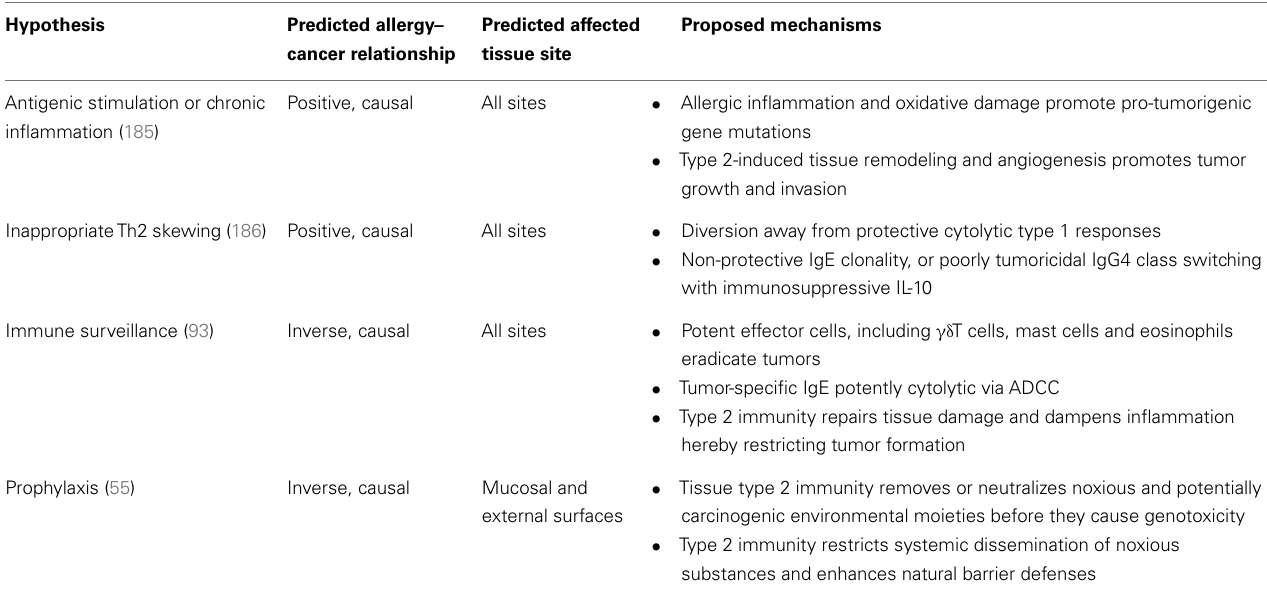
Table 2 | Proposed hypotheses explaining associations between type 2 immunity/allergy and cancer